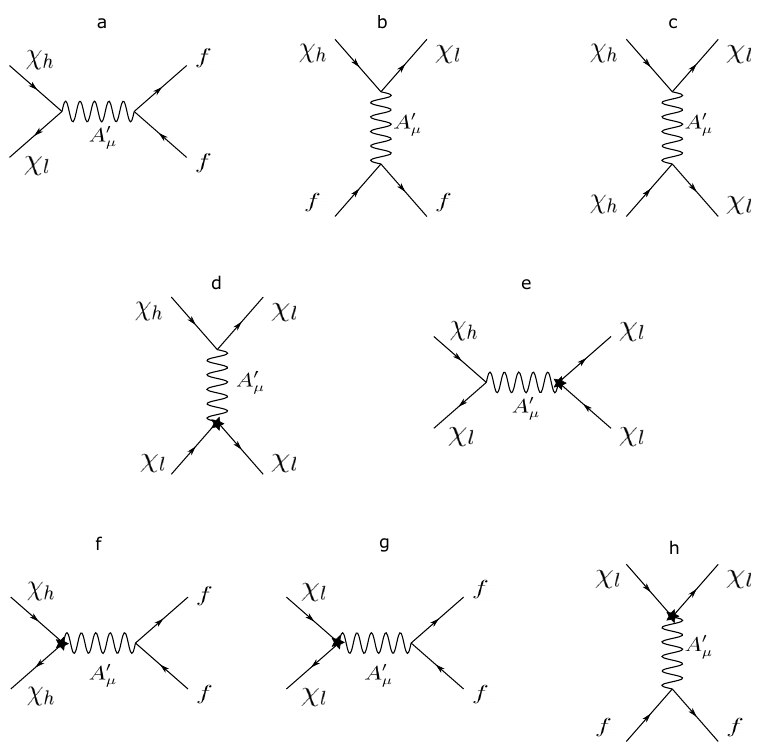
Figure 1 . Feynman graphs for the different possible scattering processes, with time running from left to right. Graphs a, b, and c in the top row are the dominant diagrams for DM annihilation, down-scattering off SM matter, and down-scattering off each other that contribute to the Boltzmann equations (3.1) and (3.2) (graphs a and b are also responsible for observable signals — CMB energy- injection and down-scattering direct detection, respectively). These rely only on the leading inelastic DM-dark-photon coupling (2.8). Graphs in the second and third lines include an elastic interaction from (2.9), denoted by a vertex with a star. This coupling arises only in the parity-breaking case ( m = m ) and is suppressed by both δ/m and a velocity factor. Graphs d and e in the second line η 6 ξ are the leading contributions to the semi-elastic processes discussed in section 4.2.3 to the depletion of the excited state, which can sometimes contribute to depletion of χ despite these suppressions. h The graphs in the bottom line are elastic contributions to DM annihilation (f and g) or scattering (h) that are mentioned in the text but negligibly